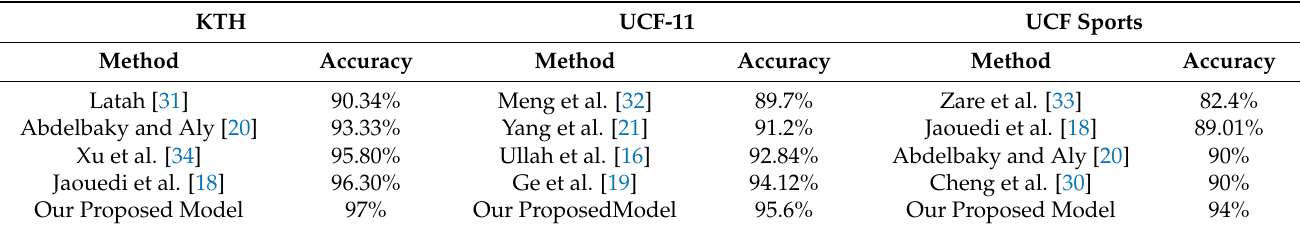
Table 7. Performance comparison with other